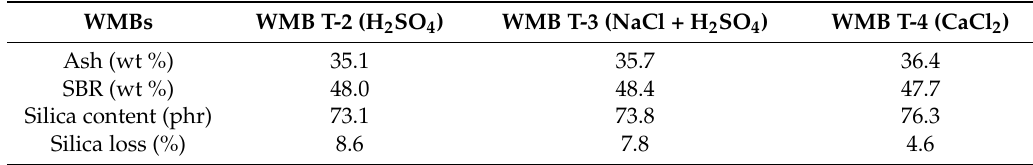
Table 6. Silica content in the ESBR WMB according to the type of coagulant.